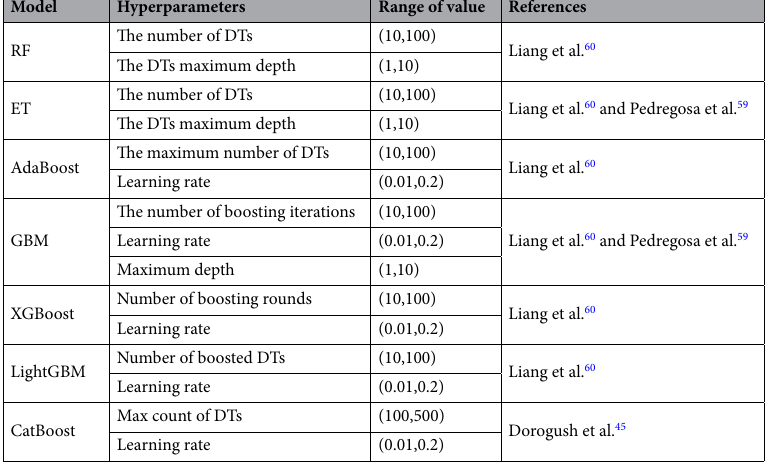
Table 4. The hyperparameters range.